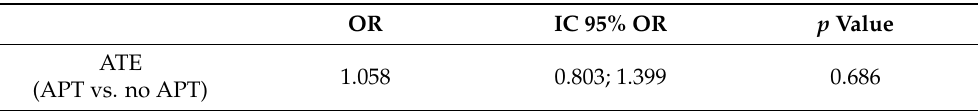
Table 5. Logistic regression model for the treatment-effects estimation with propensity score